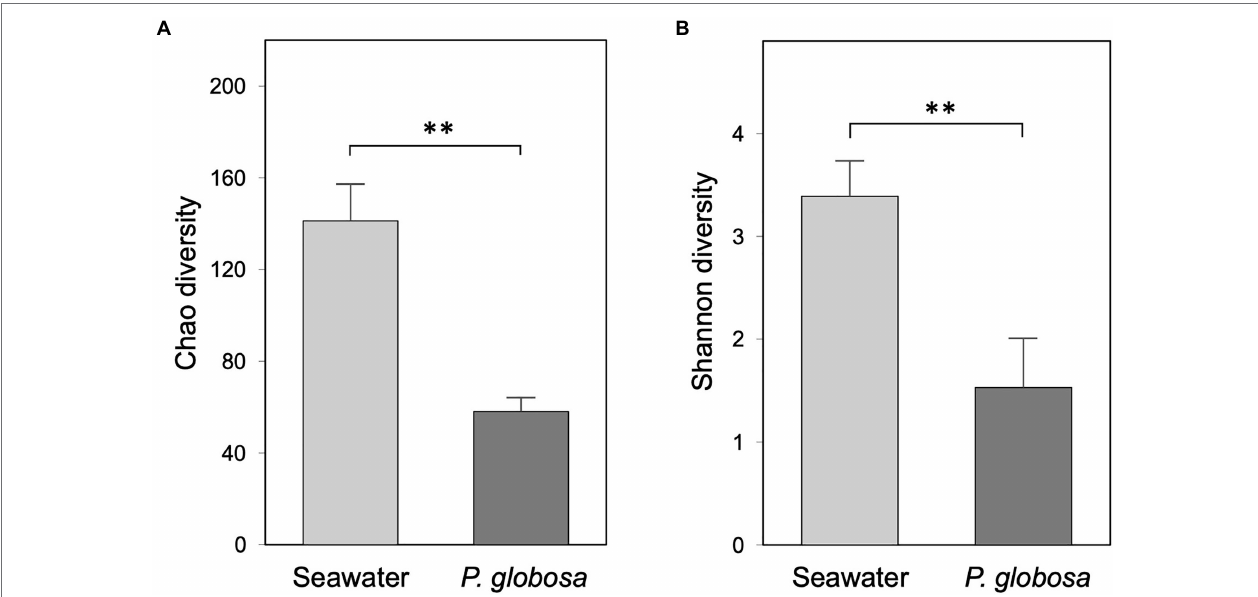
FIGURE 2 | Bacterial community alpha-diversity of ambient seawater and Phaeocystis globosa intracolonial fluid as expressed by the Chao diversity (A) and Shannon diversity (B) indices. Values are means of triplicates ± SD. The asterisks on the bar chars represent the statistical significance of the difference (Student’s t test, ** p <